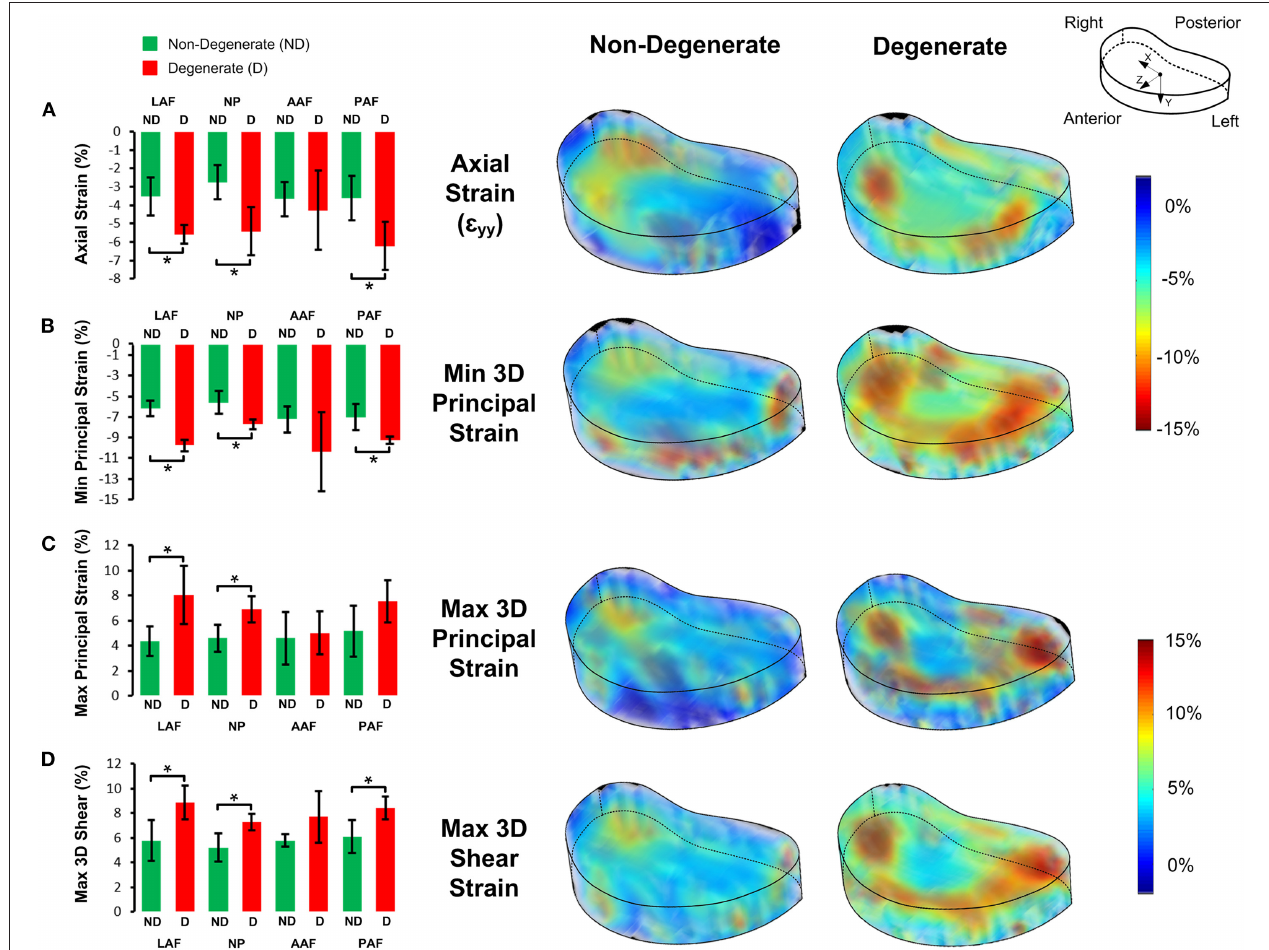
FIGURE 5 | Bar plots of the 3D strain distributions in non-degenerate (ND) and degenerate (D) IVDs in the four anatomical regions (LAF = lateral annulus fibrosus, N P = nucleus pulposus, AAF = anterior annulus fibrosus, and PAF = posterior annulus fibrosus) for the (A) axial ( ε yy ), (B) minimum principal, (C) maximum principal, and, (D) maximum 3D shear strain components (left). The bars, and error bars represent the average and SD of strain values, respectively and an asterisk (*) denotes significant differences ( p < 0.05). Transparent views of 3D strain maps for a typical non-degenerate and degenerate IVD are shown on the